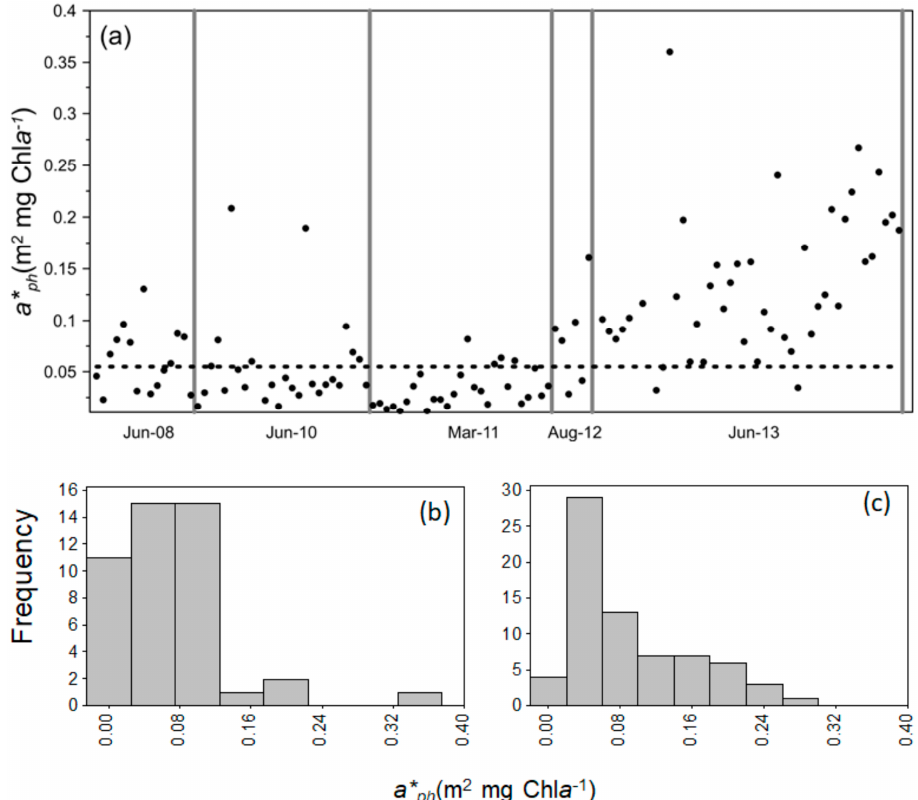
Figure 5. ( a ) In situ a* ph (m 2 mgChla − 1 ) variability for all cruises analyzed in this study, including the value used in GIOP and GSM ( a* ph = 0.055 m 2 mgChl a − 1 , dotted line). Also indicated are the frequency histograms for ( b ) UGC and ( c ) NGC.